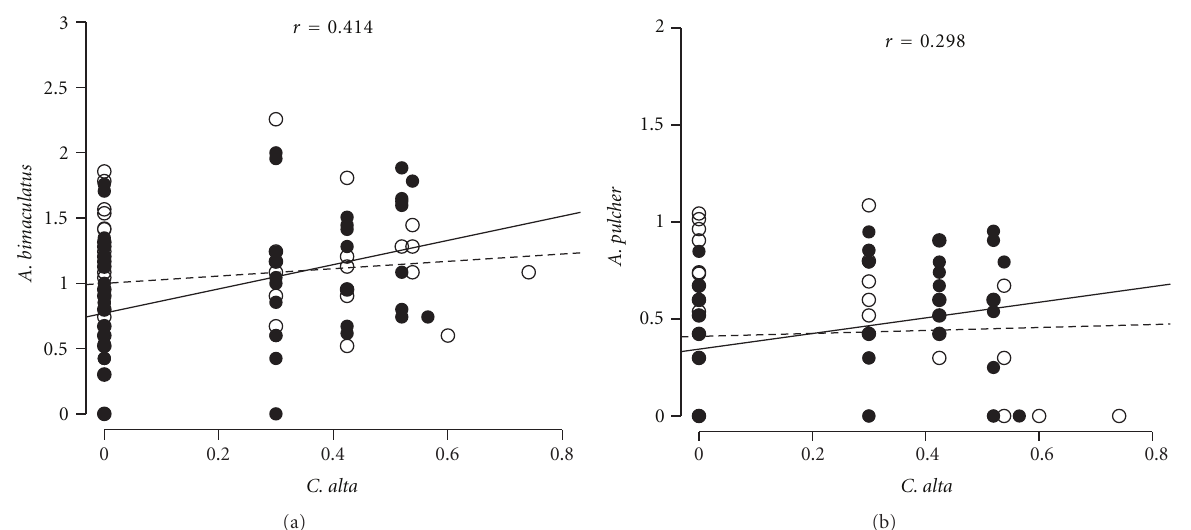
Figure 2: Pearson’s correlation analyses of square-root transformed mean counts of Astyanax bimaculatus (a) and Aequidens pulcher (b) observed within 1m radii of the prey cue introduction sites in the presence of the top predator, Crenicichla alta . Poecilia reticulata cues, closed points; Rivulus hartii cues, open points. Significant linear relationships ( P < 0 . 05) are indicated by solid lines; nonsignificant relationships are indicated by dashed lines for illustrative